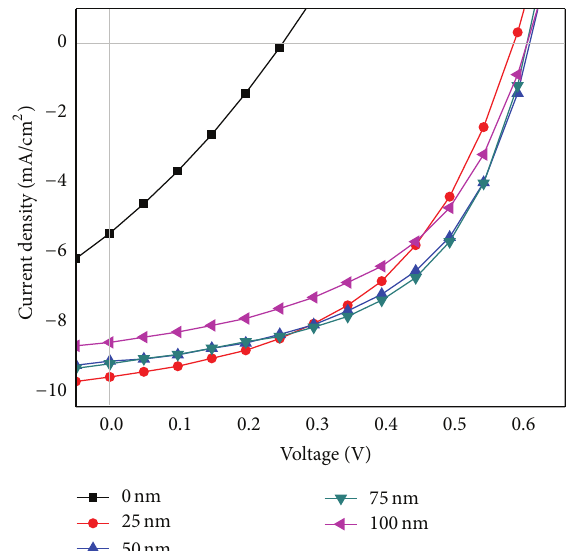
Figure 5: The transmittance spectra of ZnO films fabricated with different substrate temperature.